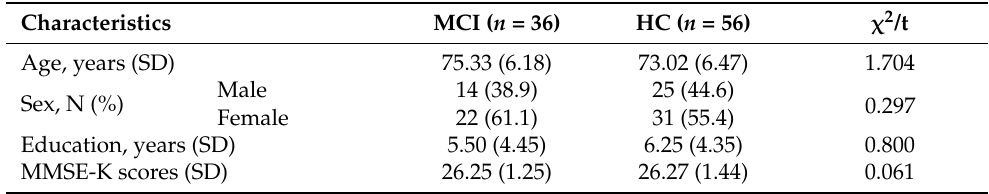
Table 1. General characteristics of the participants ( n = 92).